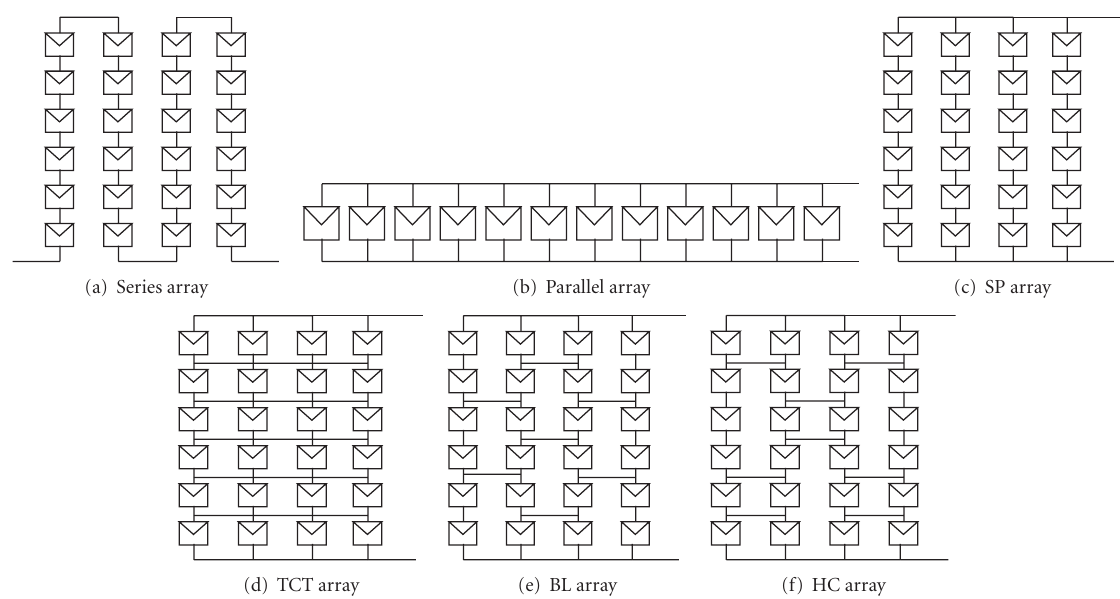
Figure 1: Schematic diagrams of SPVA